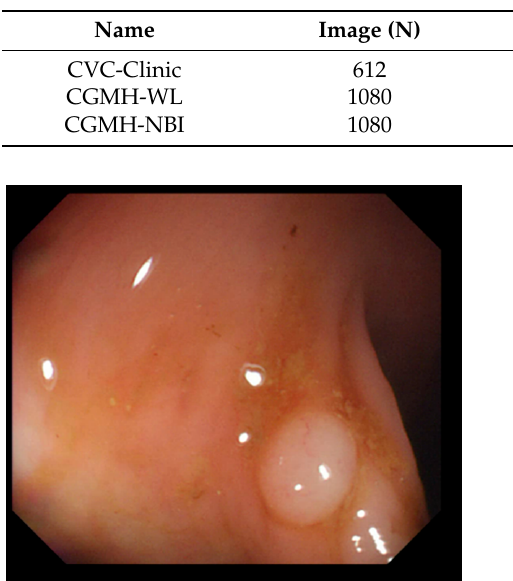
Figure 4. Colonoscopy image.